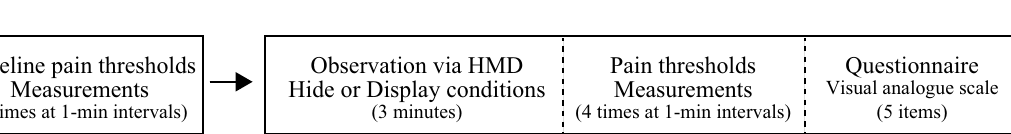
Figure 1. Experimental setup and view conditions. ( A ) The participant was fitted with a head mounted display, a thermal probe, and remote control. They observed themself from the right side via the display on which real time images were projected from a stereo camera. ( B ) In the test condition, represented by “Hide,” they opened and closed their hand while keeping their elbow out of sight. ( C ) In the control condition, represented by “Display,” they performed the same movements but kept their elbow in sight. Note that these pictures were staged with one of the authors for illustrative purposes. Informed consent for publication was obtained from the author shown in this figure.